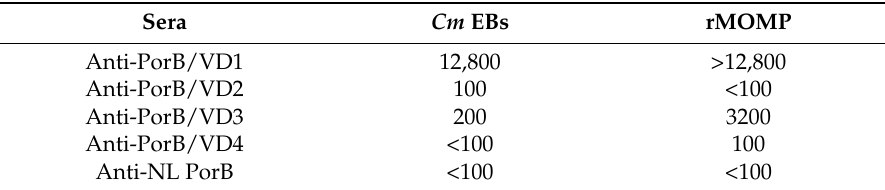
Table 3. ELISA antibody titers to Cm UV-inactivated EBs or rMOMP using two-fold serial dilutions of pooled sera from immunized mice.